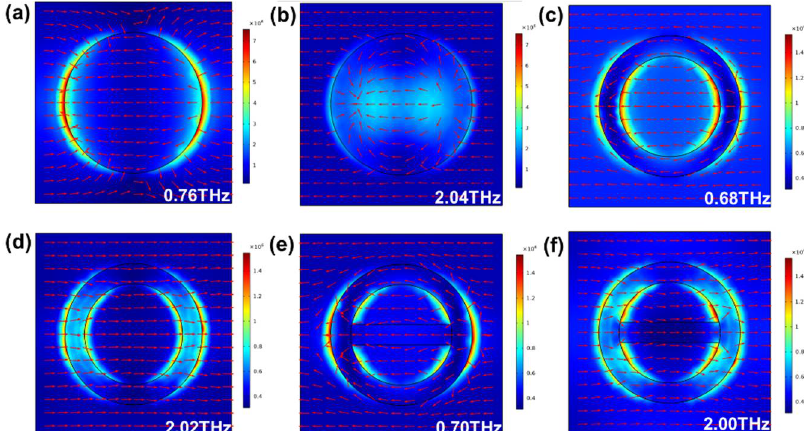
Figure 5. Electric field distribution of top disk-patterned graphene of the unit cell corresponding to ( a ) 0.76 THz and ( b ) 2.04 THz. Electric field distribution of top ring-patterned graphene of the unit cell corresponding to ( c ) 0.68 THz and ( d ) 2.02 THz. Electric field distribution of top circled minus-patterned graphene of the unit cell corresponding to ( e ) 0.70 THz and ( f ) 2.00 THz.